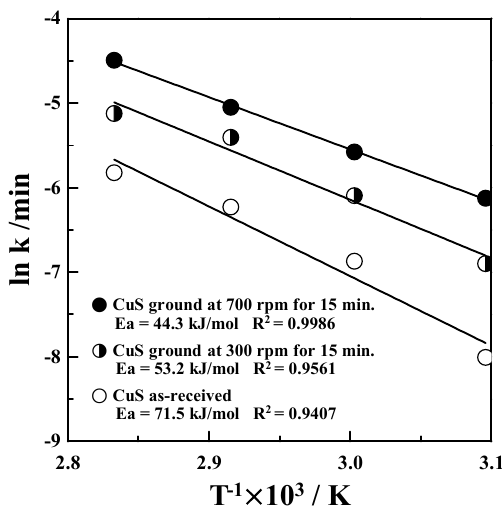
Figure 6. Arrhenius plots for the leaching of Cu from three different types of CuS. Plots of ln k versus 1/ T were straight lines with correlation coefficients of 0.9407 and 0.9986